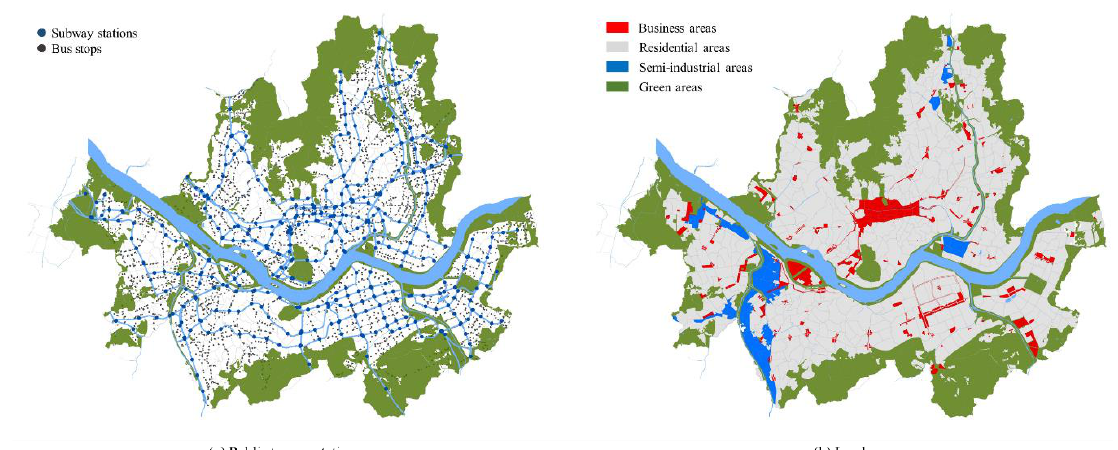
Figure 2. Public transportation and land use information in Seoul (map data sources: [66,67]). Note: Maps were created by the authors with data sources publicly available.